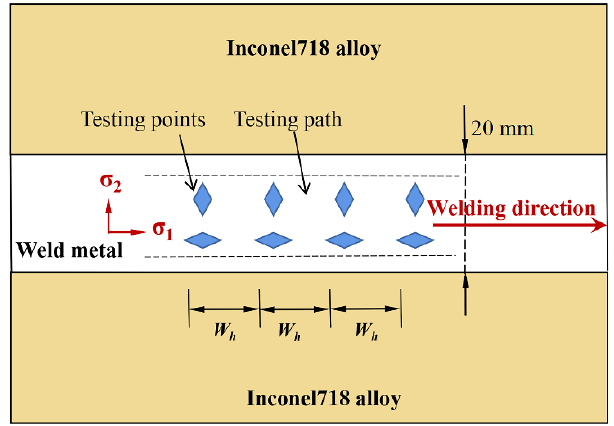
Figure 6. Inconel 718 weld zone residual stress measurement diagram.